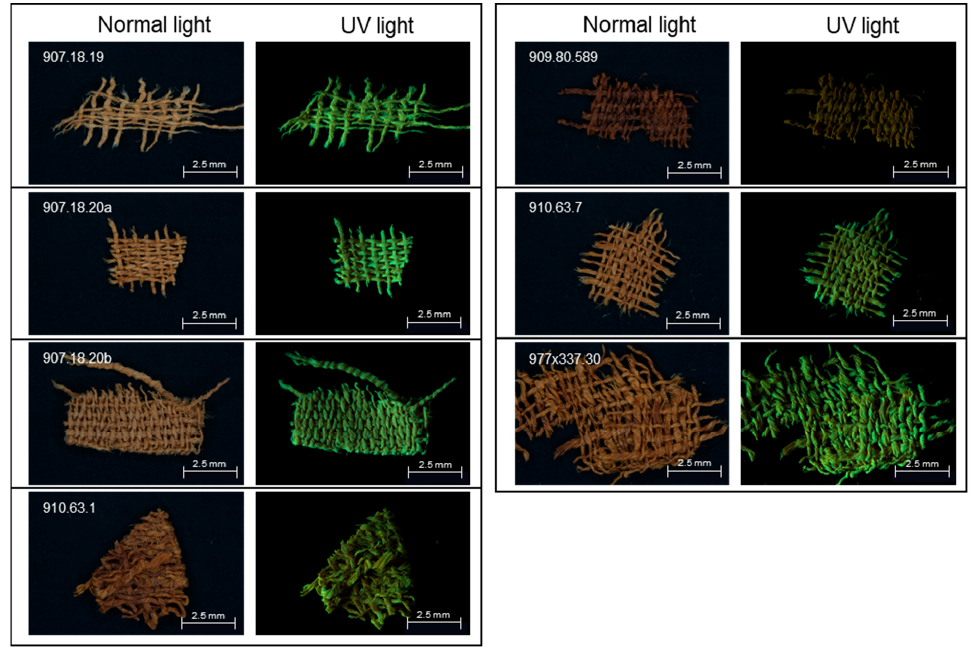
Figure 2. Photomicrographs of small samples from the seven linen fragments. The images were acquired under normal and UV light